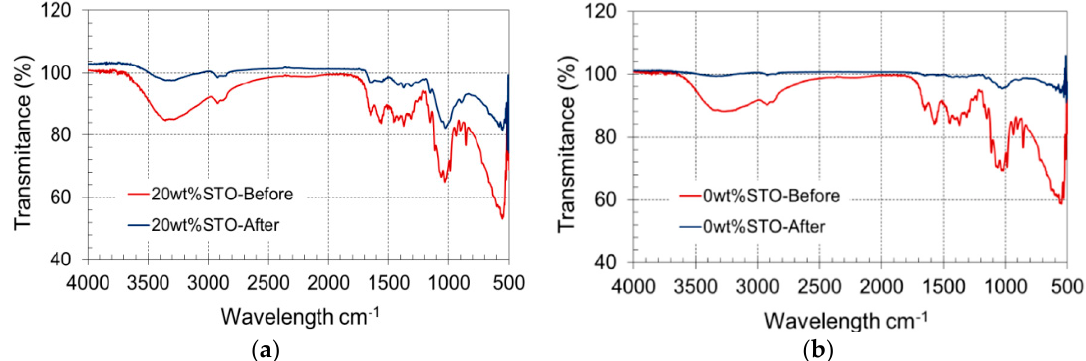
Figure 12. ( a ) Fourier transform infrared spectra for bio-composites made of 25 v% of cellulose in HCl solution with 0 wt. % STO; ( b ) 20 wt. %.